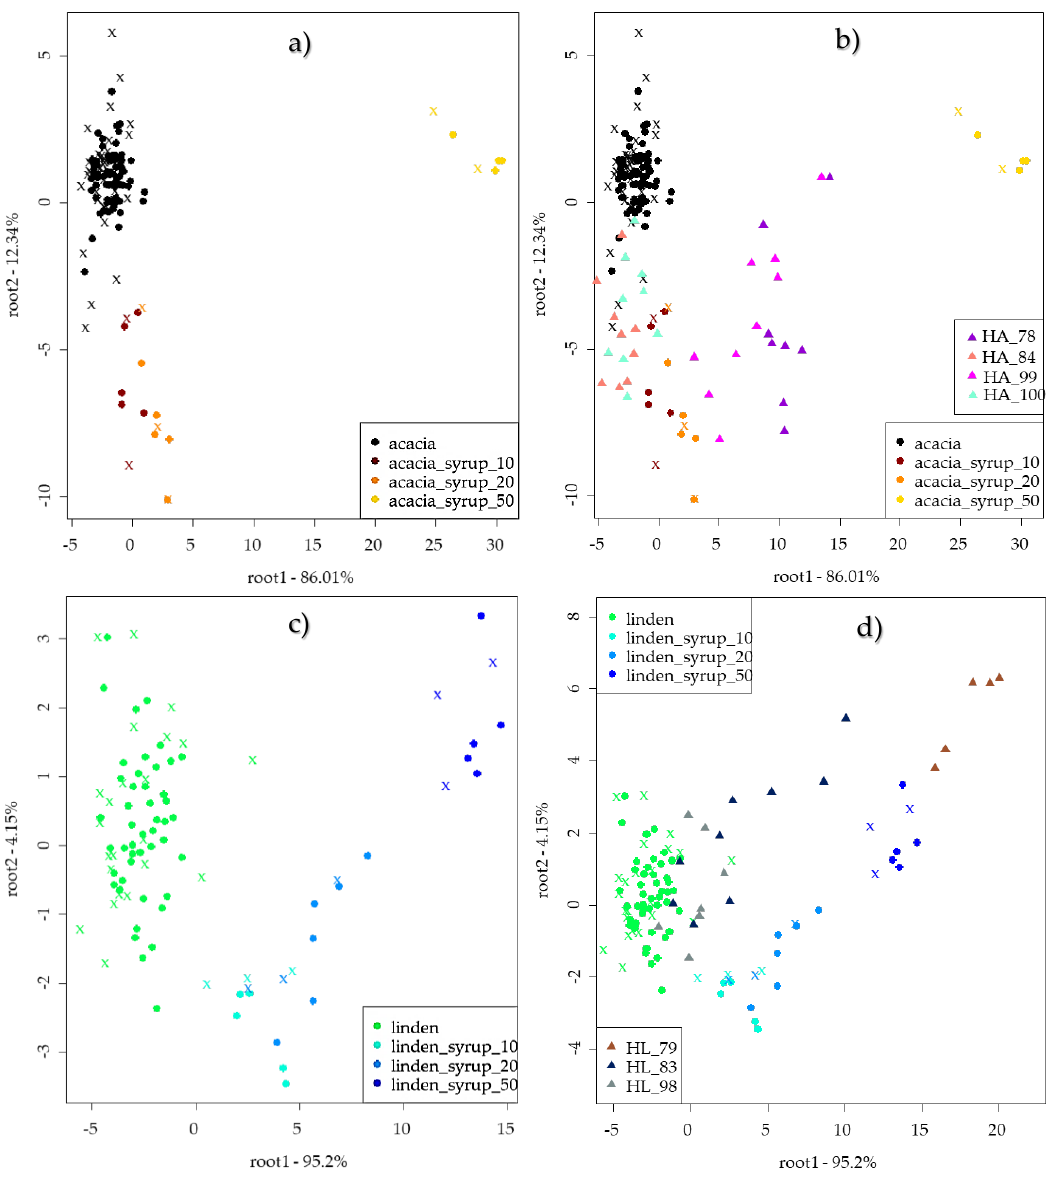
Figure 3. Results of the electronic nose LDA model for classification of authentic and adulterated acacia ( a ) (n= 127) and linden ( c ) (n= 94) honeys and models for independent prediction with EUnonEU blends for acacia ( b ) (n=127+35) and linden ( d ) (n= 94+21) honeys; training, validation and independent prediction.